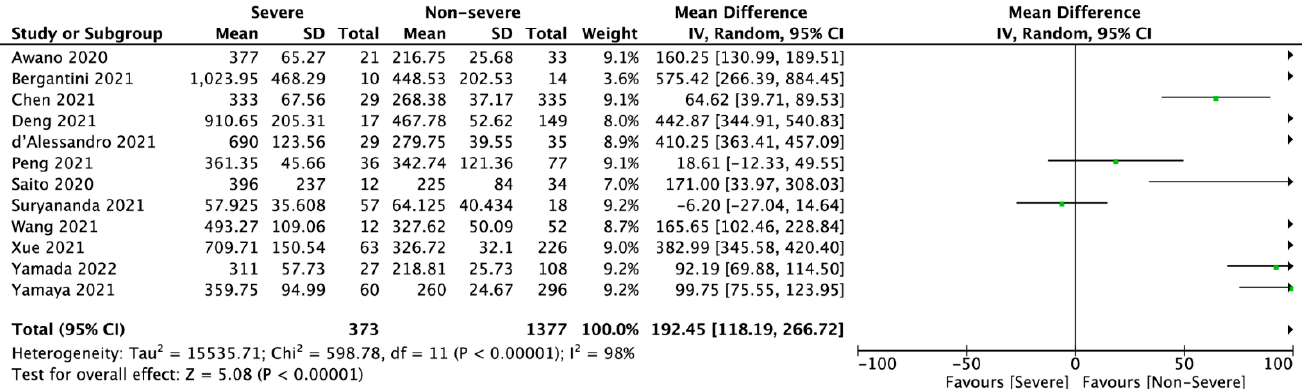
Figure 3. Forest plot of Krebs von den Lungen-6 levels (U/mL) among severe and non-severe COVID-19 patients. The center of each square represents the mean differences for individual trials, and the corresponding horizontal line stands for a 95% confidence interval. The diamonds represent pooled results [5,8,14,19,20,23–29].